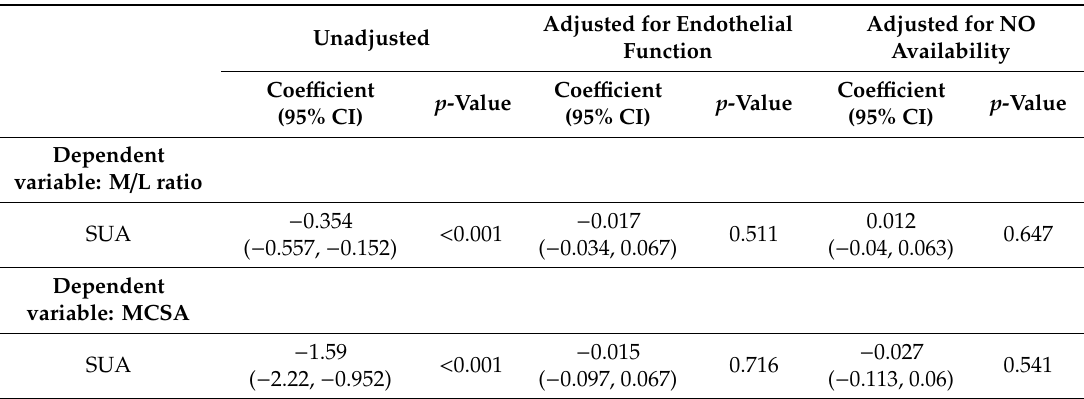
Figure 1. Fractional polynomial regression analysis for the association between continuous levels of serum uric acid (SUA) and ( A ) media-to-lumen ratio (M / L ratio) ( n = 162 subjects) and ( B ) media cross-sectional area (MCSA) ( n = 157 subjects). Serum uric acid is modelled as a second-degree fractional polynomial. A second-degree fractional polynomial with a linear and a quadratic term of SUA presented the optimal model fit to describe the relationship between SUA levels and remodeling parameters. Table 2. Change of the relationship between SUA and parameters of vascular remodeling following adjustment for endothelial function and nitric oxide (NO)